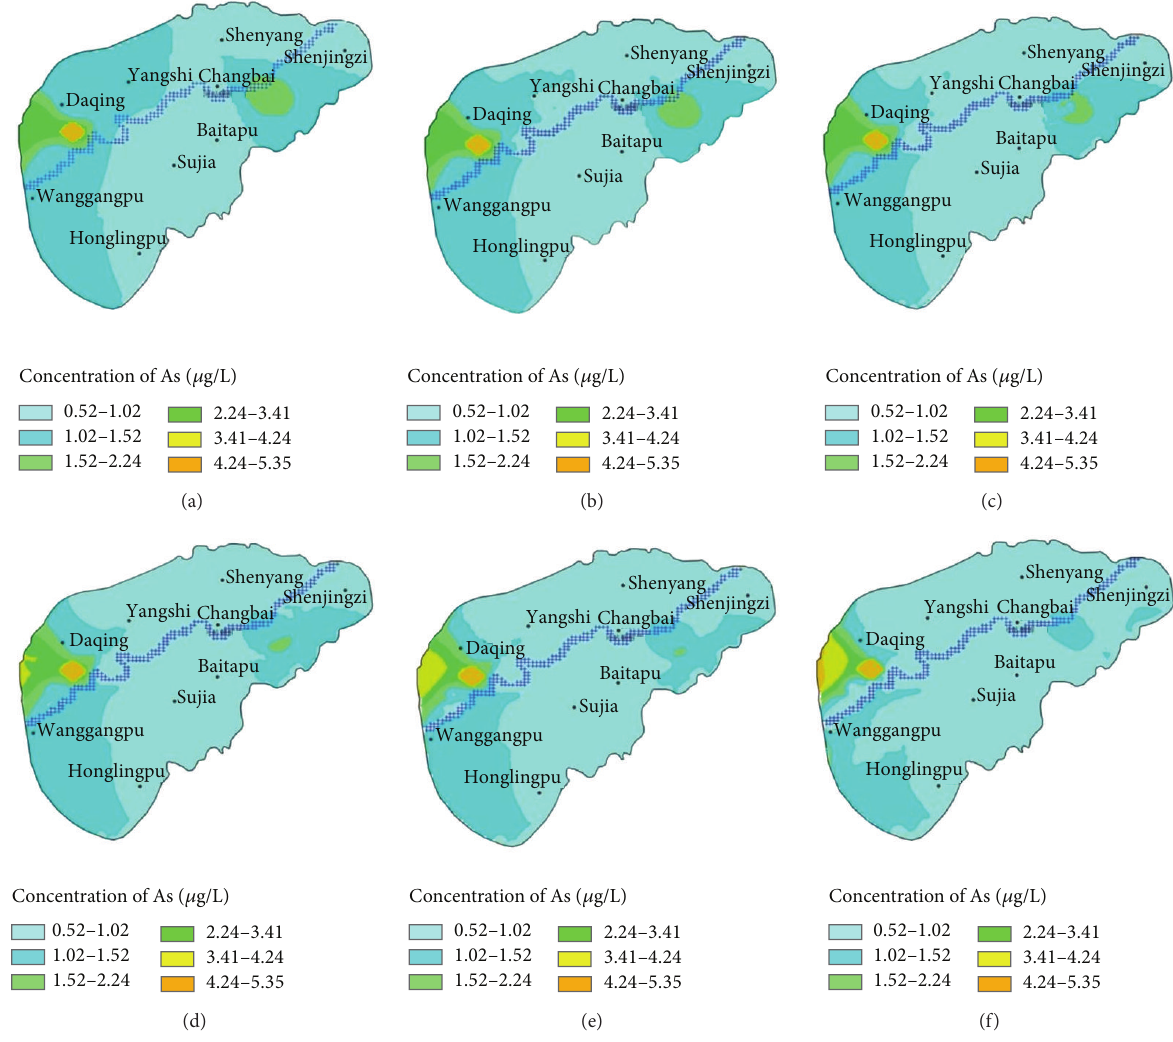
Figure 6: Diffusion and transport of As in shallow aquifer with addition of a pollution source. (a) Distribution of initial content; (b) after 1 year; (c) after 2 years; (d) after 3 years; (e) after 5 years; (f) after 10 years.